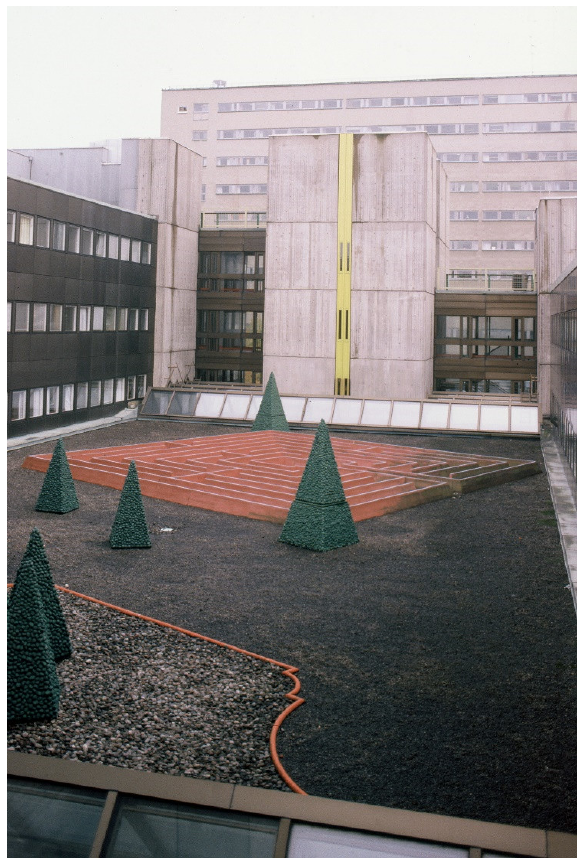
Figure 4. Courtyard of Garnisonen with artwork by Sivert Lindblom. Photo by Claes Caldenby.